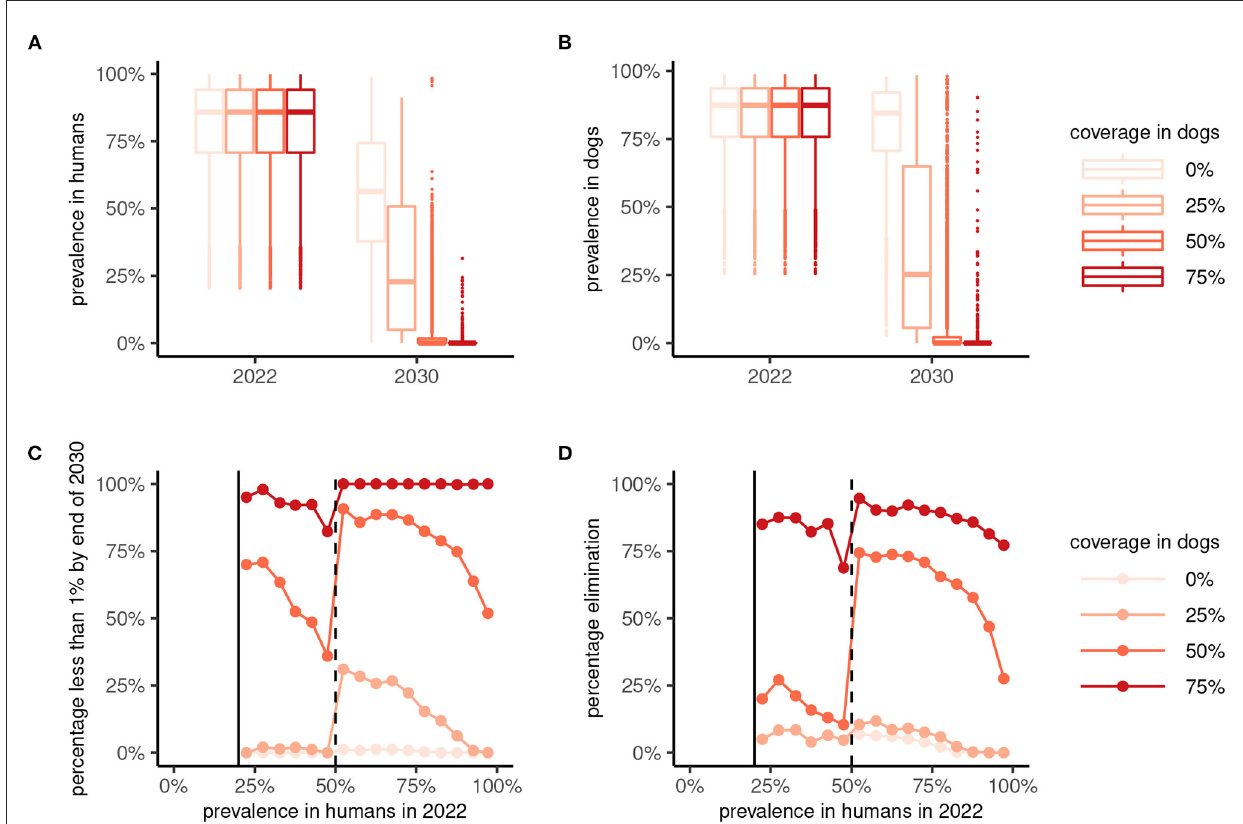
FIGURE5 Effectiveness of 8 years of human-only or “One Health” (human plus dog) mass drug administration (MDA) against Ancylostoma ceylanicum . Boxplots show the prevalence of A. ceylanicum in humans (A) and dogs (B) at endemic equilibrium in 2022 and after 8 years of MDA at the end of 2030. Human-only MDA is indicated by a coverage in dogs of 0 % (lightest color), with the coverage in dogs for One Health MDA varied between 25 % and 75 % as indicated. The bottom panels show the percentage of parameter sets yielding a prevalence < 1 % in humans (C) or interruption of transmission [elimination; R e < 1; (D) ] by 2030 against the endemic prevalence in 2022. MDA was not simulated for an endemic prevalence in humans of < 20 %